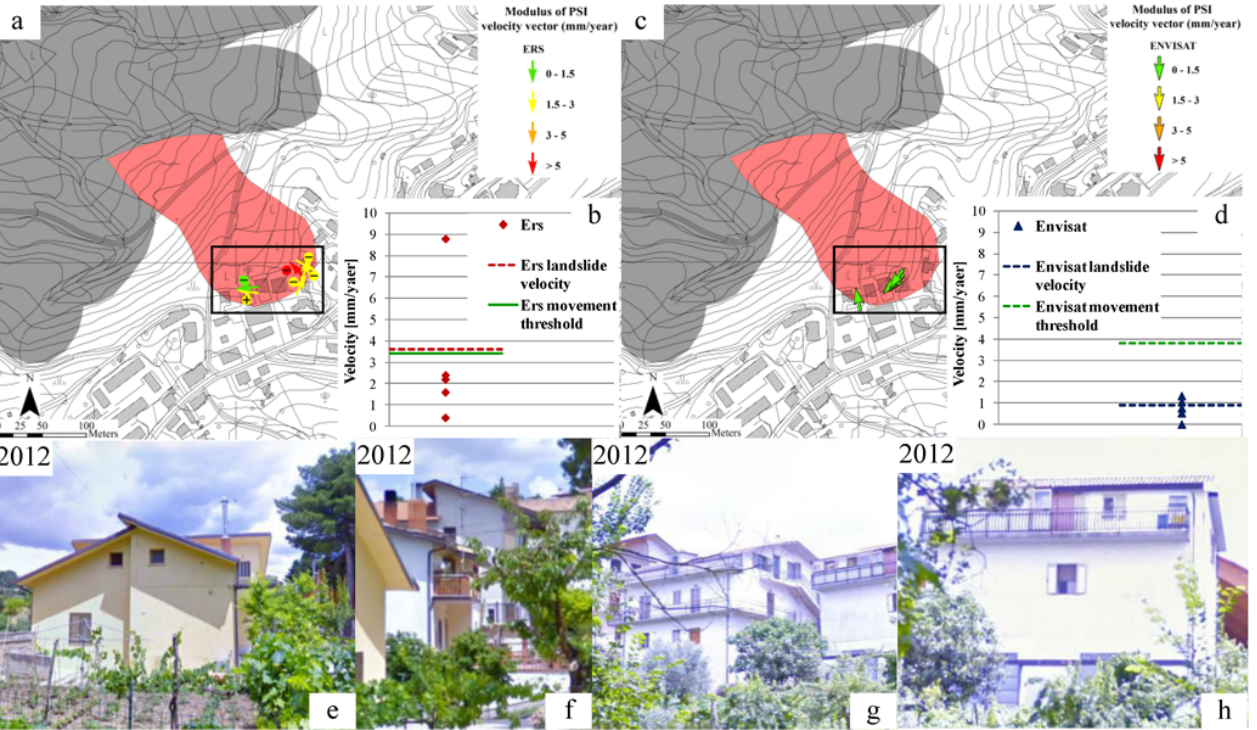
Fig. 24. A dormant rotational slide in the municipality of San Giorgio La Molara (Benevento Province): (a) the inventory map with ERS PS velocity vectors and indication of the increasing ( + ) or decreasing (–) trend of the displacement time series; (b) diagrams of the ERS velocity values for the PS located within the landslide boundaries and indication of both the computed landslide velocity and the computed landslide movement threshold; (c) the inventory map with ENVISAT PS velocity vectors; (d) diagrams of the ENVISAT velocity values for the PS located within the landslide boundaries and indication of both the computed landslide velocity and the landslide movement threshold; (e, f, g, h) different views of buildings located in the head of the landslide referring to the survey carried out in 2012.